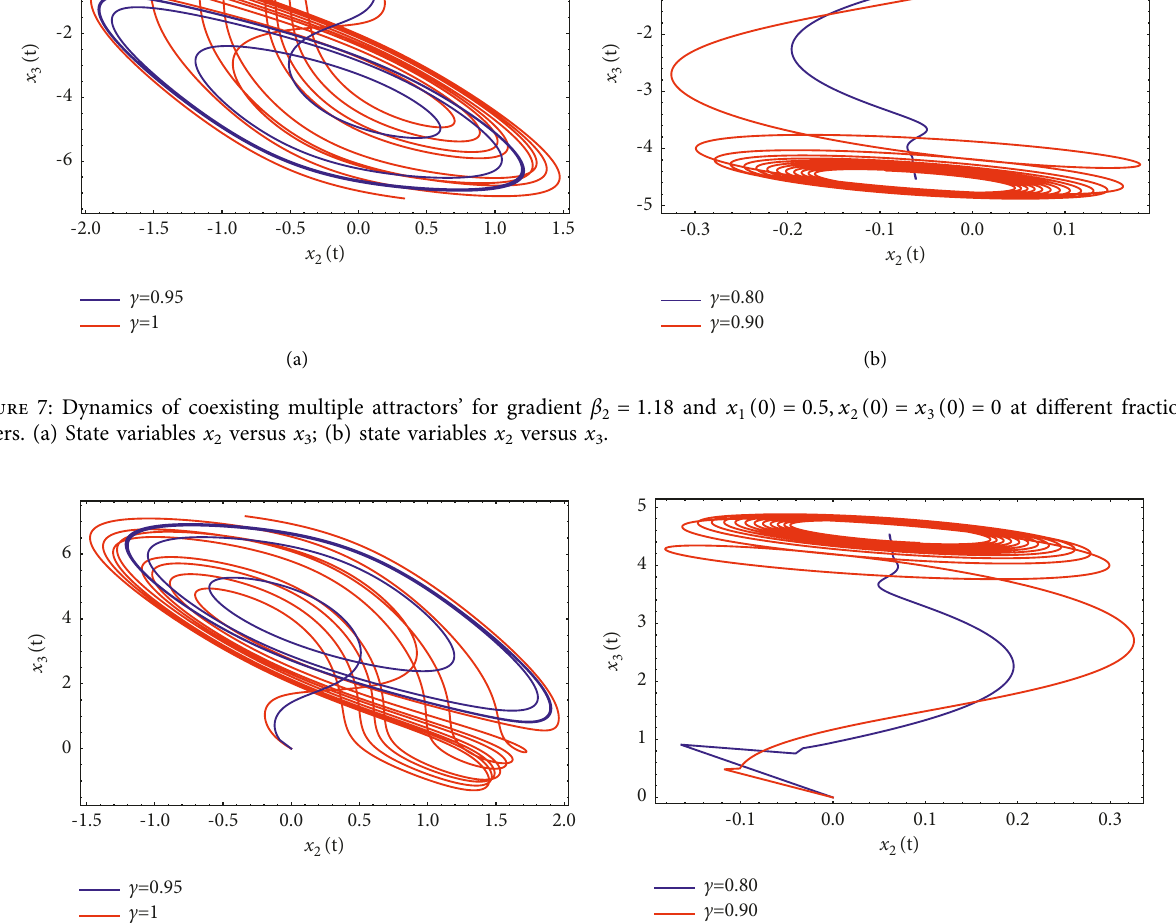
� 1 . 18 and x ( 0 ) � − 0 . 5 ,x ( 0 ) � x ( 0 ) � 0 at different fractional 1 2 3 2